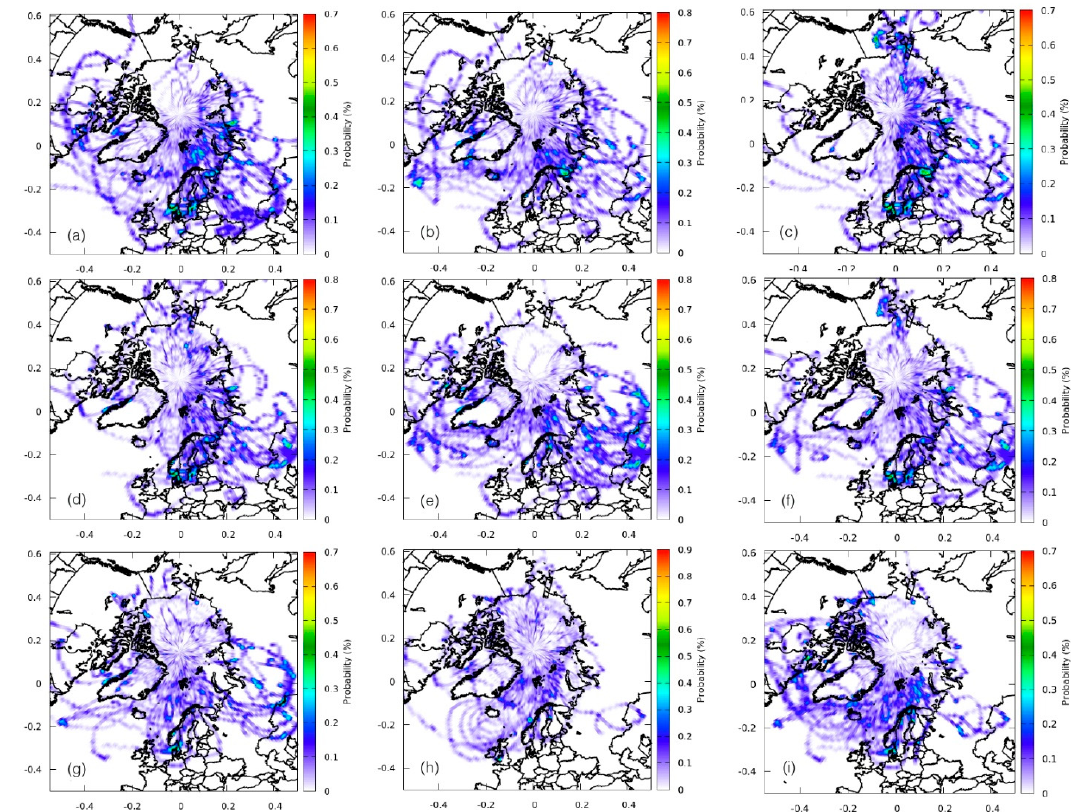
Figure 2. Ninetieth-percentile PSCF probability plots for Al ( a ), Fe ( b ), Mn ( c ), Ti ( d ), Cr ( e ), V ( f ), Cu ( g ), Zn ( h ), and Ni ( i ) in PM 10 , computed by our code using four trajectories per day. Table 2. Source regions, geochemical markers and daily occurrence of the dust events over Ny-Ålesund in the period 27 February–21 October 2015. Source Region Elements Daily Dust Events Eurasia Al, Fe, Mn, Ti, Cr and V Iceland Fe, Cr and V Greenland Fe, Cr and Ti Alaska Mn and